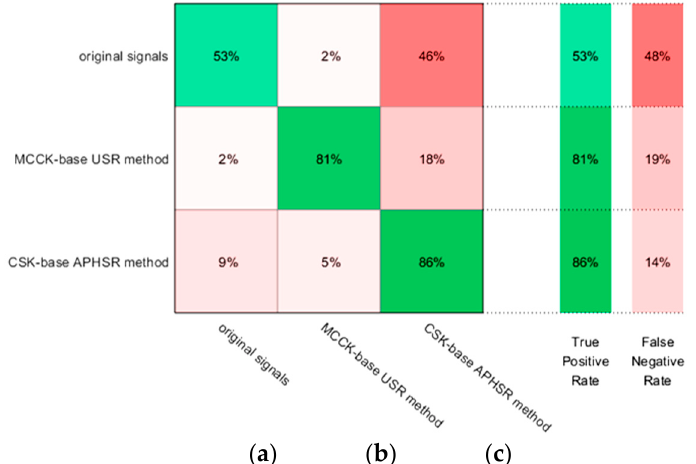
Figure 9. Recognition rates of outer ring: ( a ) original signals, and signals processed by ( b ) MCCK- based USR method and ( c ) CSK-based APHSR method.